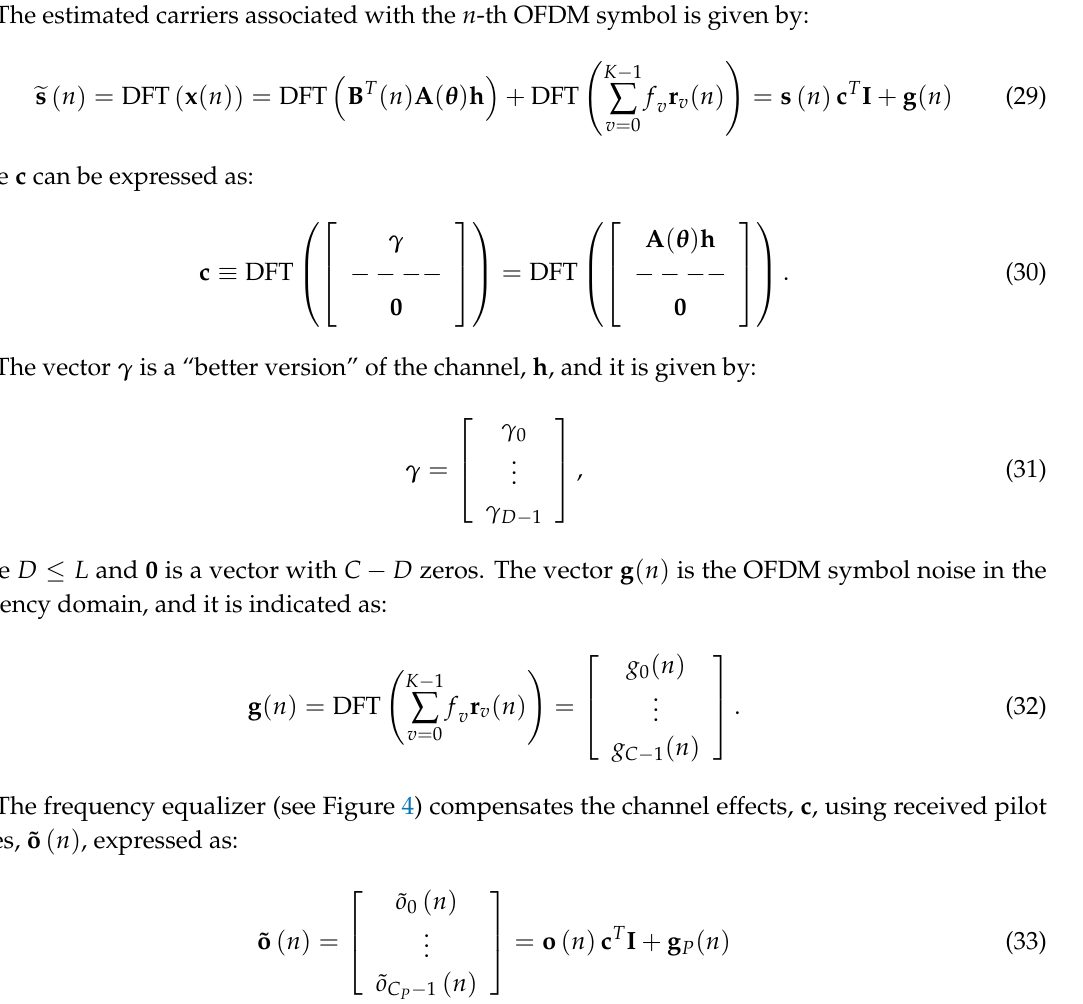
Figure 4. Illustration of the discrete baseband OFDM receiver. DFT, Discrete Fourier